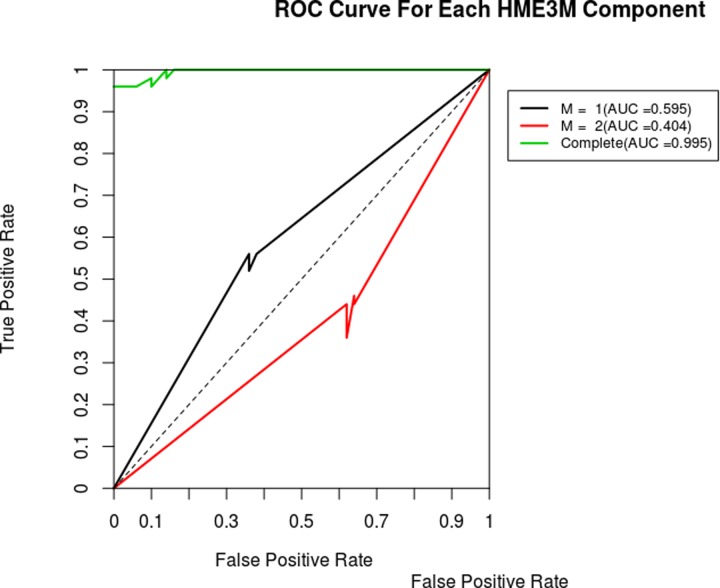
Receiver operating characteristic (ROC) curve for correlated path classification model of lipid metabolic pathways based on transcriptome data for RRMM.Diagnostic plot of the result from the path classification model for RRMM transcriptome data. ROC curves are shown for each component (M1, M2), which represent a path structure pattern. This gives information about which components is associated with RRMM and NDMM. A ROC curve with an AUC < 0.5 relates to RRMM. Conversely, ROC curve with AUC > 0.5 relates NDMM. Complete ROC represents the performance of the classifier using both components.